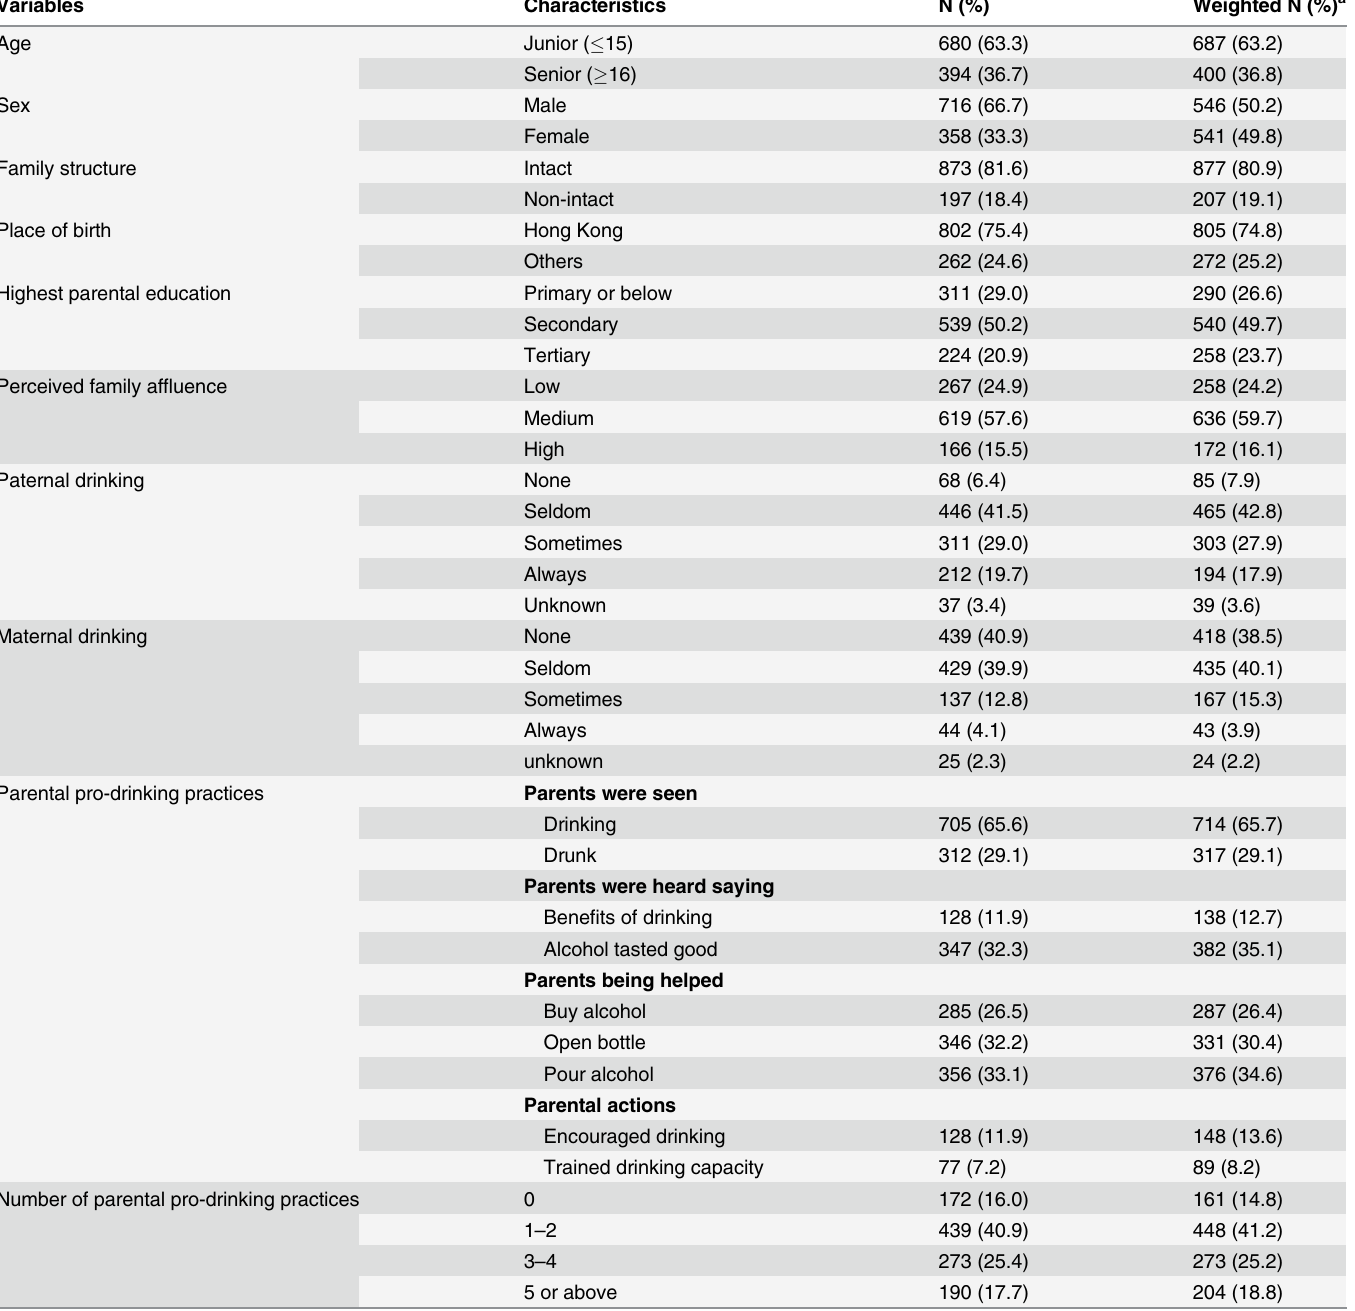
Table 1. Characteristics of subjects with at least one current drinking